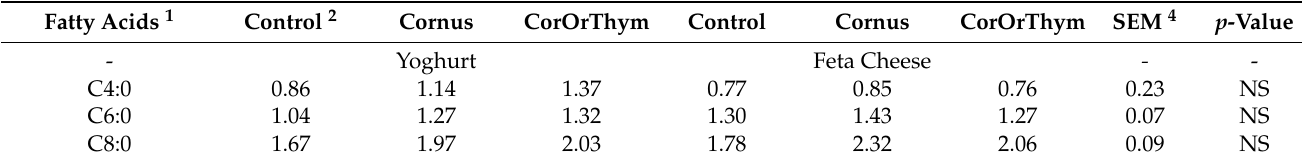
Table 8. Effects of diet supplementation with cornus extract and oregano and thyme essential oils on fatty acid profile of yoghurt and Feta cheese (% of total identified fatty